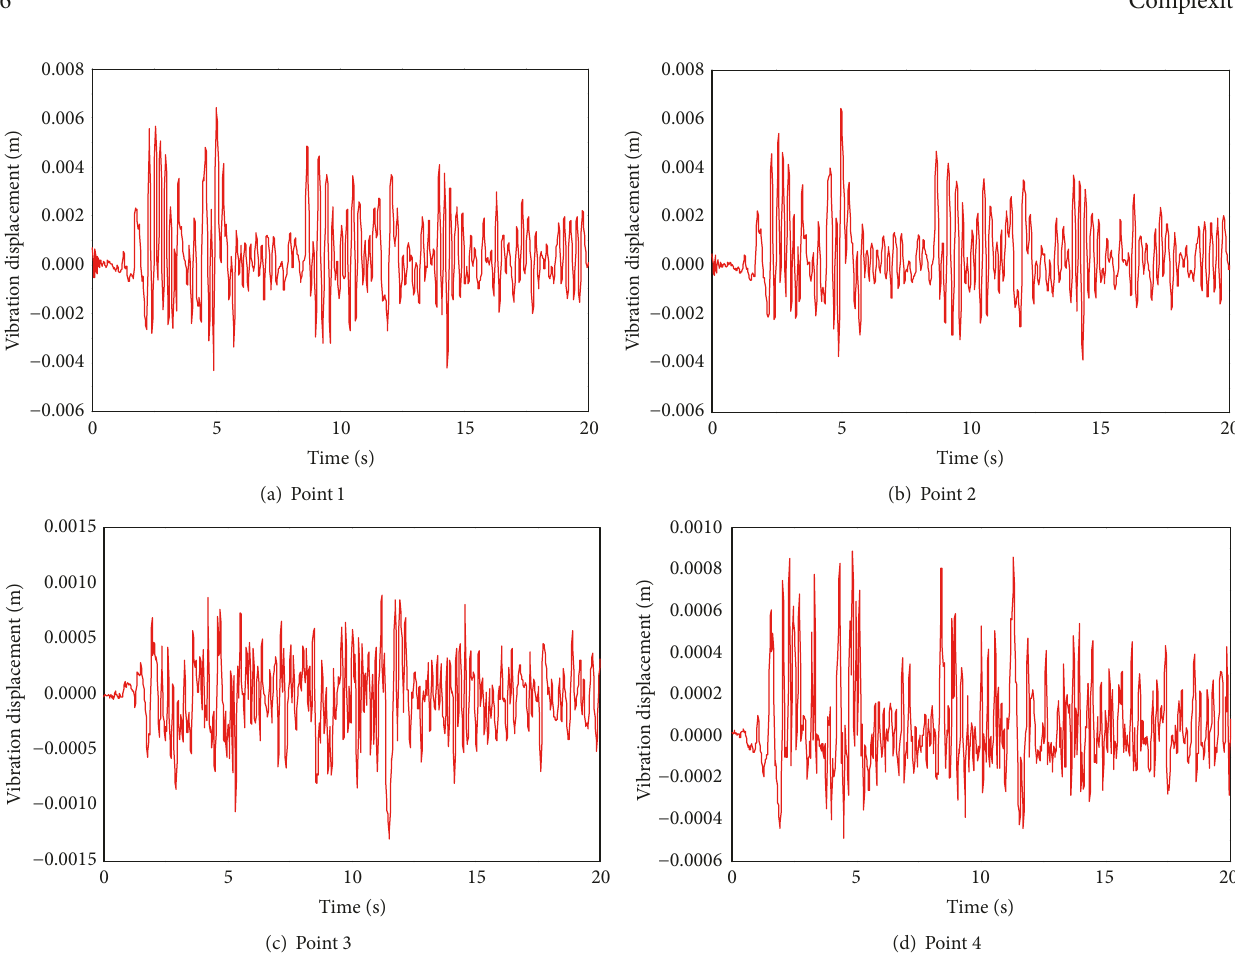
Figure 6: Dynamic responses of observed points on the masonry structure in